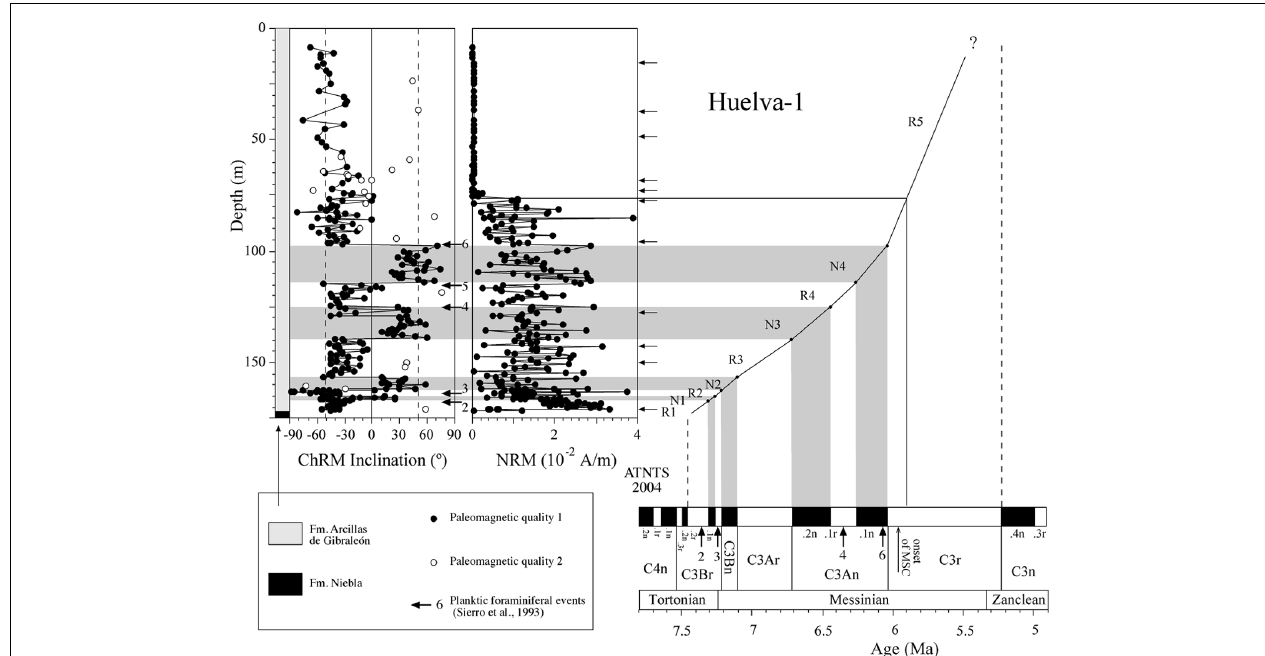
FIGURE 3 | Magnetostratigraphic and biostratigraphic results from the Huelva-1 borehole, and correlation of polarity intervals with the astronomically tuned Neogene timescale (ATNTS) of Lourens etal. (2004). Type 1 samples are those with well-defined linear trends that enable accurate calculation of their direction and give rise to optimal polarity determinations.Type 2 samples have poorly developed linear trends and